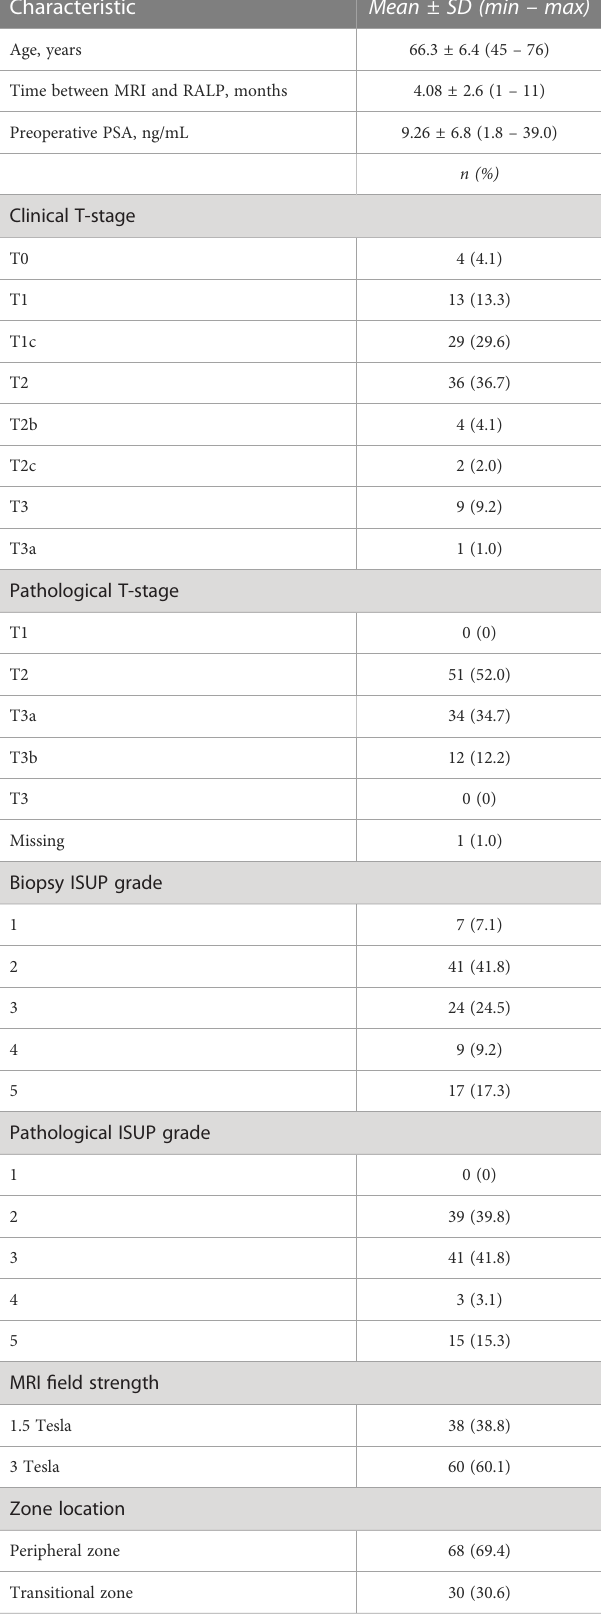
TABLE 3 Patient characteristics